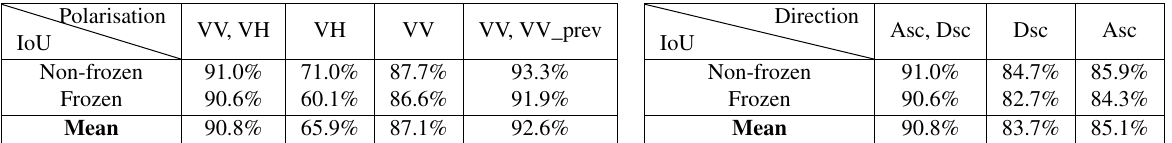
Figure 8: Qualitative results for lake St. Moritz on a non-frozen day (row 1 ), lake Silvaplana on a frozen day (row 2 ), and lake Sils on a transition day (row 3 ). For each lake we show the Sentinel-1 composite image (column 1 ), the ground truth (column 2 ), the predicted frozen probability map derived from the network logits (column 3 ), and the corresponding binary classification map (column 4 ). Additionally, column 5 shows a corresponding Sentinel-2 image for better visual interpretation. Table 7: Per-class- and mean IoU values of frozen and non-frozen classes with different polarisations (left table) and orbits (right table). Data from all three lakes from winter 2016 - 17 was tested using a model trained on the data from all three lakes from winter 2017 - 18 . Asc and Dsc denotes ascending and descending orbits